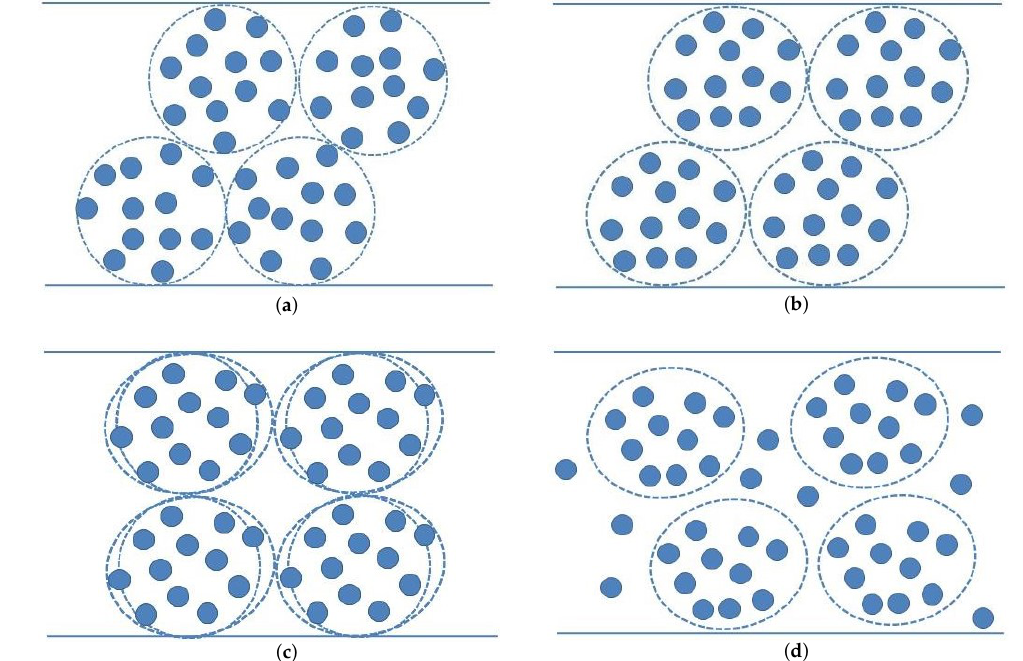
Figure 2. Blob model illustrating the microstructure evolution during yielding: ( a ) intact gelation structure; ( b ) microstructure during elastic dominant viscoelastic creeping; ( c ) microstructure with tangency geometry at critical point of structural yielding; ( d ) breaking of colloidal aggregates after the structural fracture of